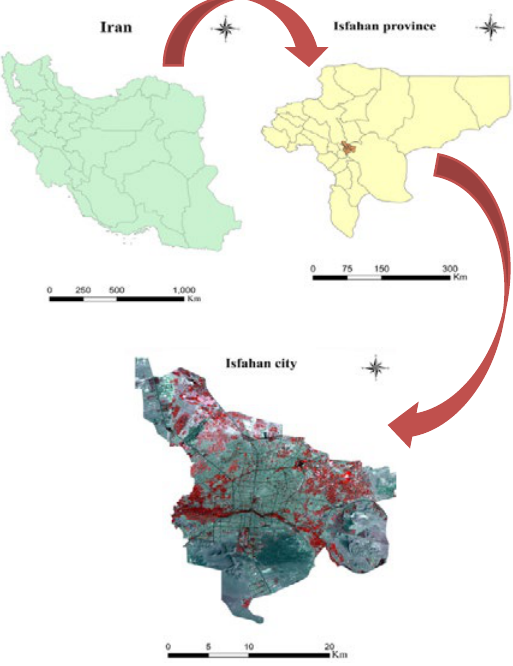
Fig. 1. Geographic location of the study area in Isfahan, Iran